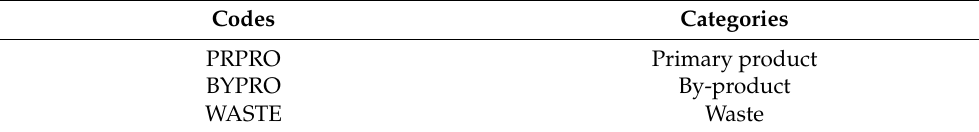
Table 4. Codes for the product